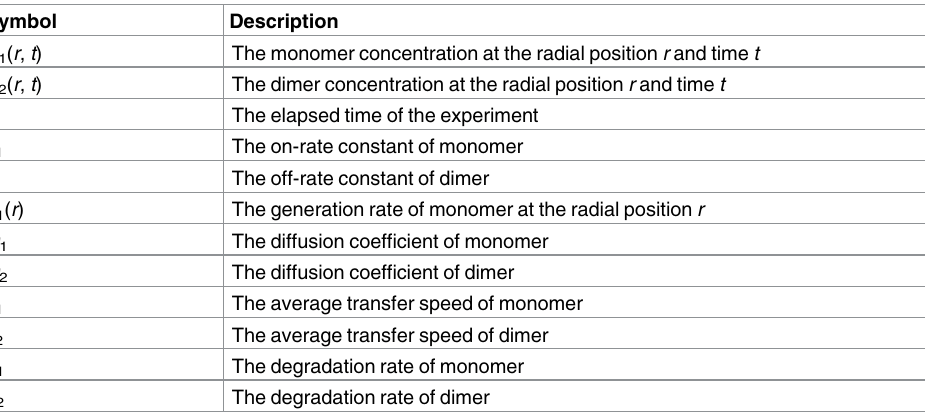
Table 1. Nomenclature of the mathematical